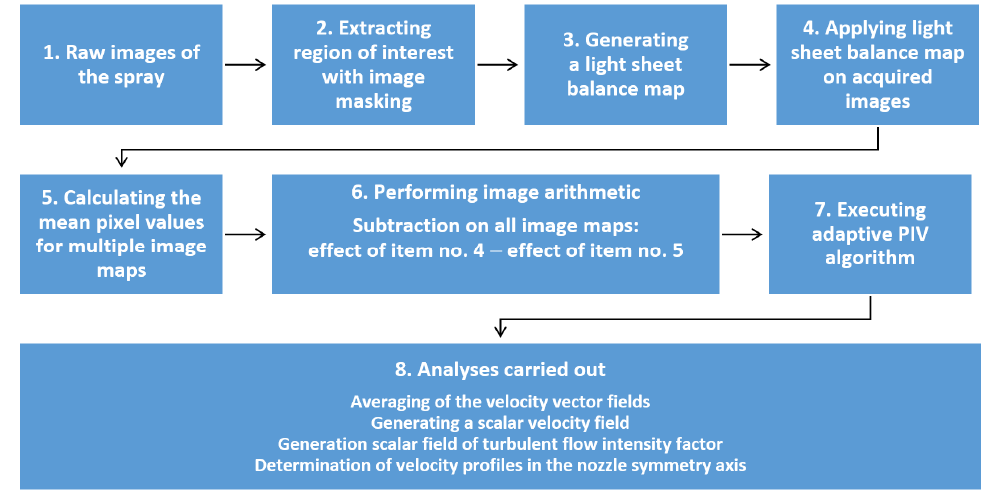
Figure 4. Block diagram of the PIV methodology.